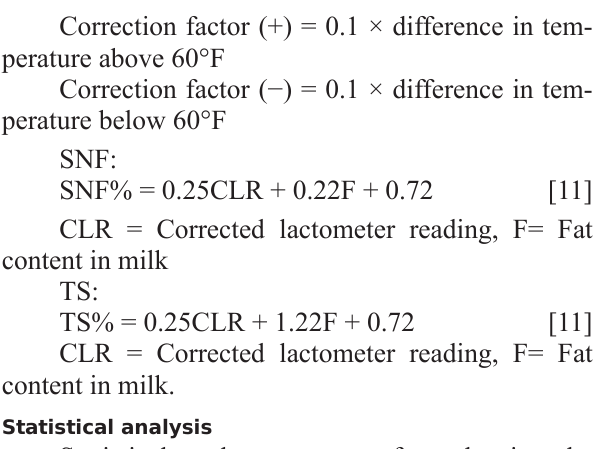
Table-4: Details of experimental buffaloes: Group IV (foggers and fans). Animal no